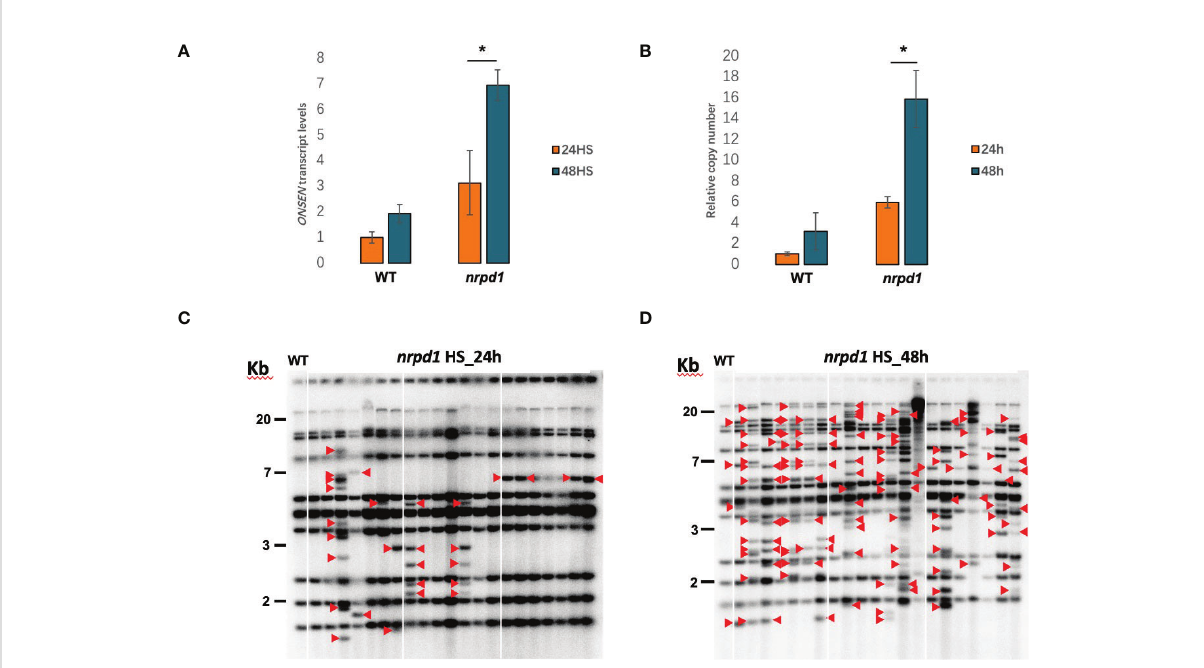
FIGURE 2 ONSEN activation affected by heat stress duration. (A, B) The relative expression levels (A) and relative copy numbers (B) of wild type and nrpd1 mutant detected by RT-qPCR and qPCR under heat-stress (HS) conditions at 24 and 48 h for ONSEN . Asterisks indicate signi fi cant differences between the 24 and 48 h HS conditions (Student ’ s t -test, P < 0.05). (C, D) Southern blotting analysis of ONSEN in the next-generation nrpd1 mutant under HS [24 h (C) and 48 h (D) ]. Seven individuals of the next generation from each of the three parent plants subjected to heat stress were analyzed. The leftmost panel in each fi gure shows the wild-type pattern under non-stress (NS) condition. Red arrows indicate new ONSEN